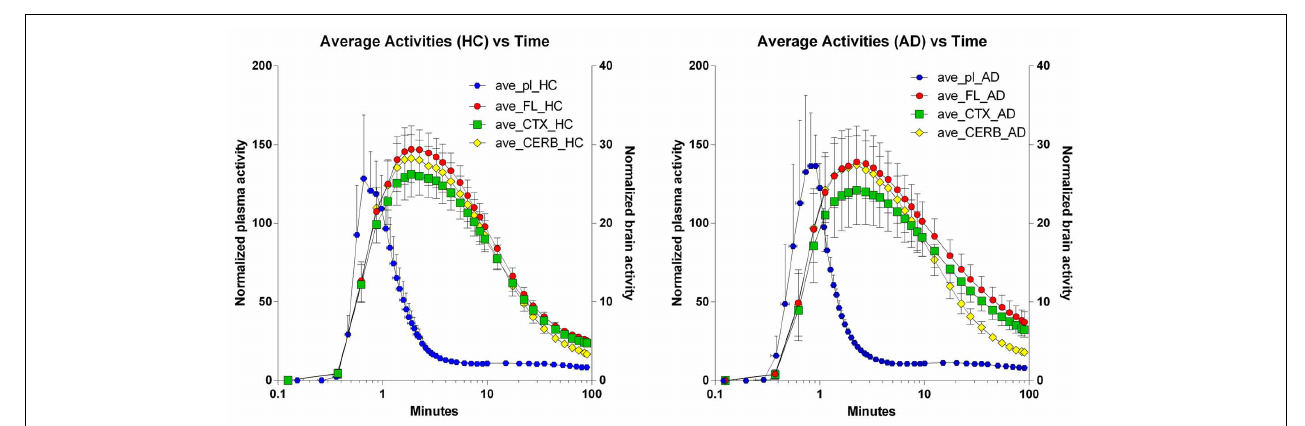
5 patients with Alzheimer’s Disease (lower row). Abscissae: Time (minutes). Ordinates: Normalized brain radioactivity (kBq/ml).